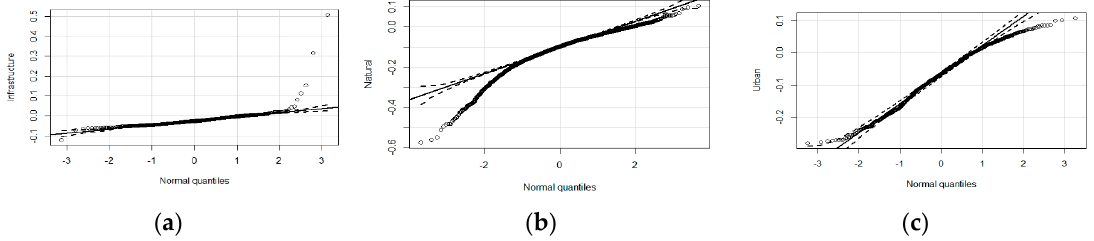
Figure 2. QQ-plots for the error in each study case: ( a ) Infrastructure, ( b ) Natural and ( c ) Urban. Table 4. Results of gaussian assessment and normality test for the test sites.